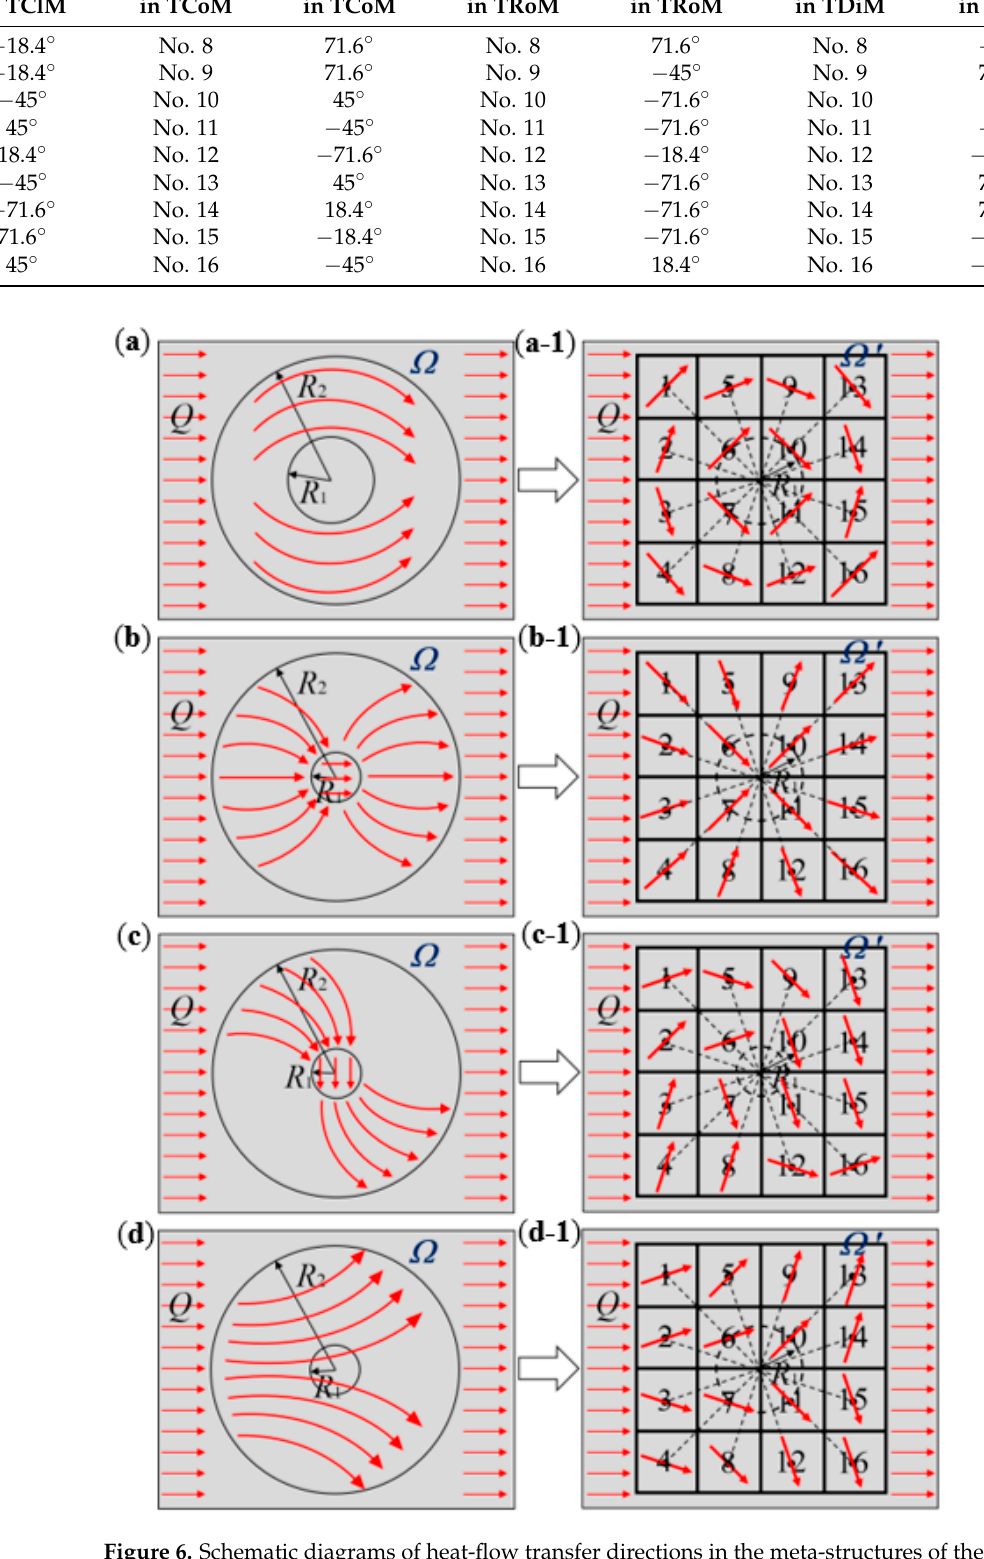
Figure 6. Schematic diagrams of heat-flow transfer directions in the meta-structures of thermal cloak ( a , a-1 ), thermal concentration ( b , b-1 ), thermal rotation ( c , c-1 ), and thermal dispersion ( d , d-1 ), before ( a – d ) and after ( a ‐ 1 – d ‐ 1 ) spatial discretization to sixteen square unit modules.